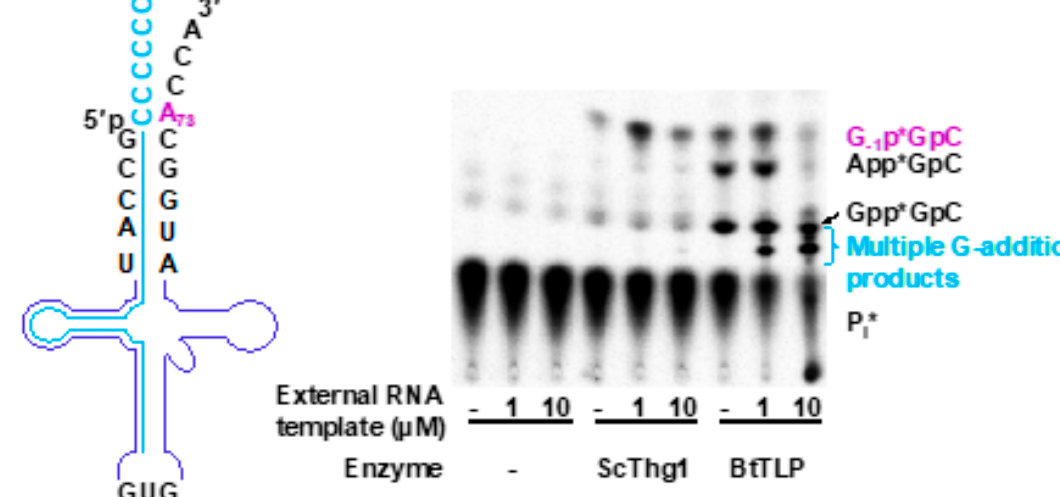
Figure 7. An external guide RNA oligonucleotide-mediated approach to manipulate nucleotide addition by Bacillus thuringiensis TLP homolog (BtTLP). ( A ) Schematic representation of tRNA His (backbone in purple) hybridized to the external guide RNA oligonucleotide template (shown in blue). ( B ) Activity assay using the external guide RNA template and analyzed by thin-layer chromatography (TLC). Identities of the labeled reaction products are consistent with the known migration patterns of these species that have been validated by previous assays [23]. Nucleotide addition was tested using Saccharomyces cerevisiae Thg1 (ScThg1) and BtTLP with varying concentrations of the external guide RNA template (0 µ M, 1 µ M, and 10 µ M, as indicated). In the absence of the guide RNA template, ScThg1 efficiently adds G − 1 and in contrast, BtTLP only weakly adds G − 1 across from A 73 (evident from the amount of the product G − 1 p*GpC, which is labeled in purple). BtTLP instead accumulates 5 (cid:48) -adenylylated and 5 (cid:48) -guanylylated intermediates (evident from the products App*GpC and Gpp*GpC, which are labeled in black respectively). In the presence of the external guide RNA template, ScThg1 still maintains its ability to add a single G nucleotide across from A 73 in S. cerevisiae tRNA His (Sc-tRNA His , as evident from the product G − 1 p*GpC shown in purple), whereas BtTLP adds multiple G nucleotides using the 3 (cid:48) -CCCCCCA of the external guide RNA oligonucleotide as a